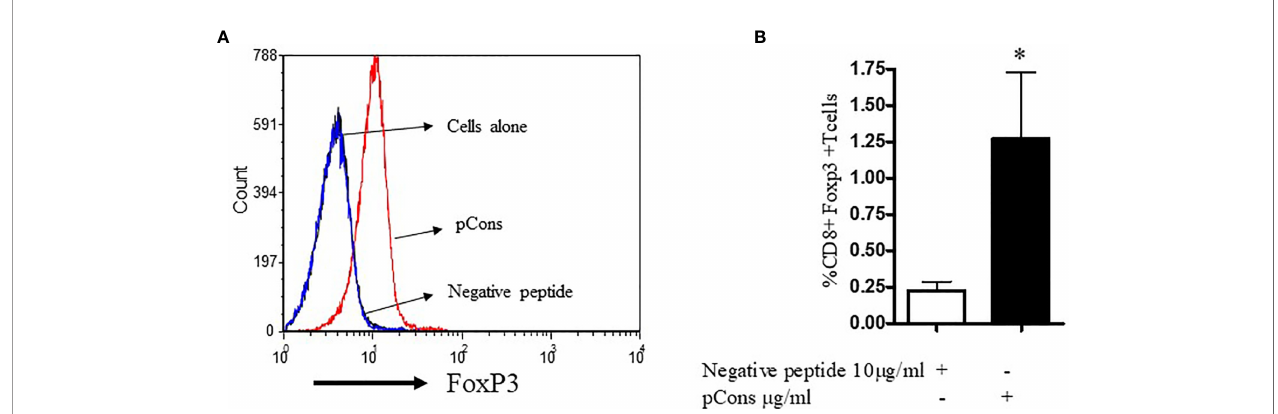
FIGURE 5 | pCons treatment increases CD8 + FoxP3 + T cells in healthy subjects. 10x10 6 peripheral blood mononuclear cells (PBMCs) were obtained from healthy volunteers (n=6). Cells were cultured with recombinant IL-2 (50 U/ml), negative control peptide A or pCons peptide (10 ug/ml) for 24-48 hours. Cells were stained with CD4, CD8, CD25 and FoxP3 fl uorochrome-conjugated antibodies. FoxP3 intracellular staining was performed after cell surface staining. Cell were fi xed and permeabilized as per manufacturer ’ s protocol. Minimum 10,000 cells were gated, and only live cells were used for data analyses. Dead cells were excluded from the analyses. (A) Mean fl uorescence intensity (MFI) of FoxP3 among naïve, negative control peptide, and pCons-treated PBMCs of healthy subjects. (B) Percent expression of CD8 + FoxP3 + T cells between negative control peptide and pCons-treated PBMCs of healthy controls. Dead cells were excluded from the analyses. Data were analyzed with FCS Express Ver. 7 ( De Novo , Ontario, Canada) *p <